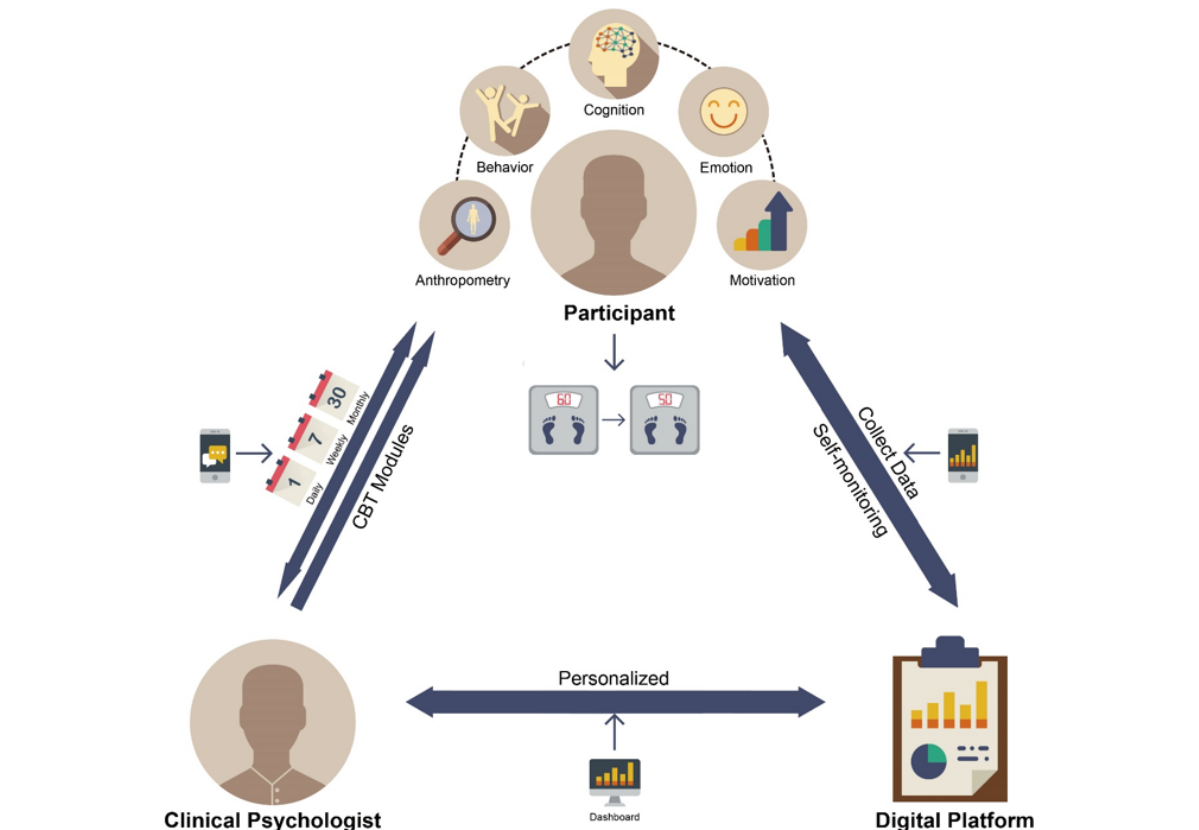
Figure 2. Diagram of the digital cognitive behavioral therapy (CBT)